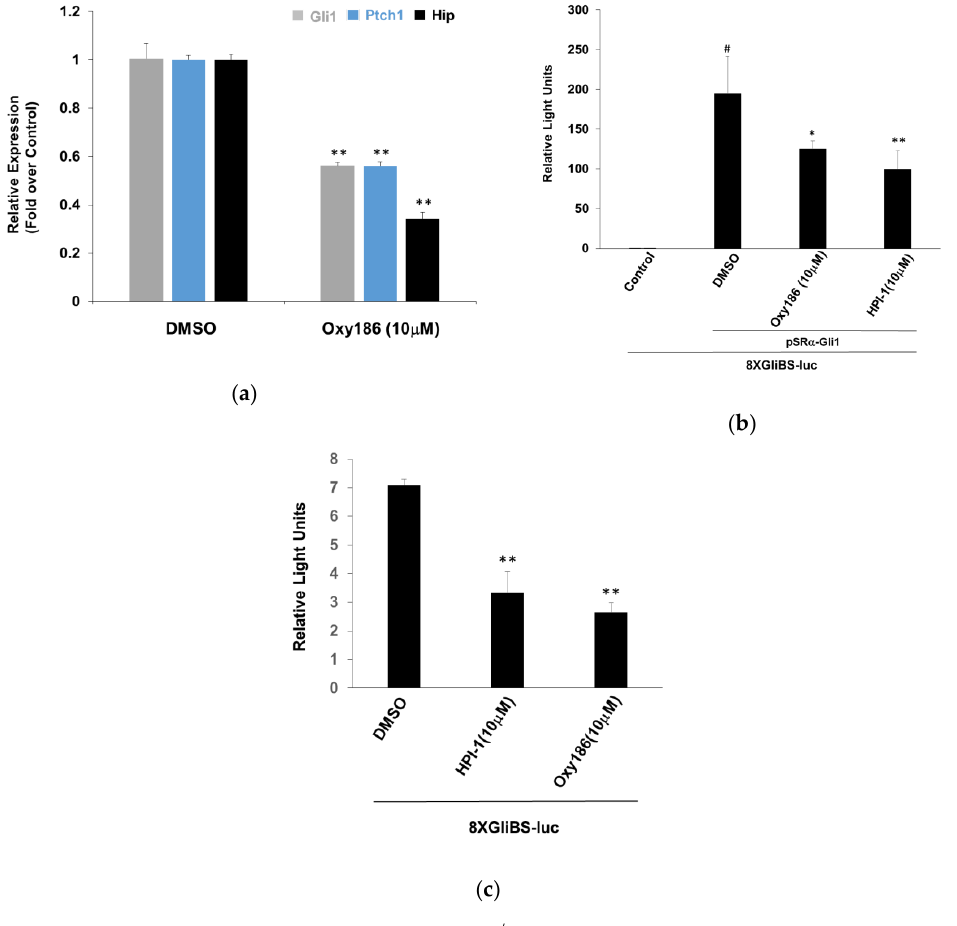
Figure 5. Oxy186 acts downstream of Smo. ( a ) Sufu − / − mouse embryonic fibroblast (MEF) cells were treated with DMEM containing 10% FBS in the presence or absence of Oxy186 (10 µM). After 72 h, RNA was extracted and analyzed by Q-RT-PCR for the expression of Hh target genes Gli1 , Ptch1 , and Hip , normalized to Oaz1 expression. ( b ) NIH3T3 cells cultured in 24-well plates were transfected with a Gli response-element reporter (pGL3b-8xGliBS-Luciferase) plasmid, a pTK-Renilla-Luciferase plasmid and a vector expressing Gli1, pSRa-Gli1. 24 h after transfection, cells were treated with the test agents as indicated for 72 h. ( c ) Sufu − / − cells cultured in 24-well plates were transfected with a Gli response-element reporter (pGL3b-8xGliBS-Luciferase) plasmid and a pTK-Renilla-Luciferase plasmid. 24 h after transfection, cells were treated with the compounds, as indicated, for 72 h. Luciferase activity was measured and normalized to the Renilla luciferase activity. Data from a representative experiment are reported as the mean of triplicate determinations ± SD (* p < 0.05 vs. DMSO; ** p < 0.01 vs. DMSO; # p < 0.01 vs.